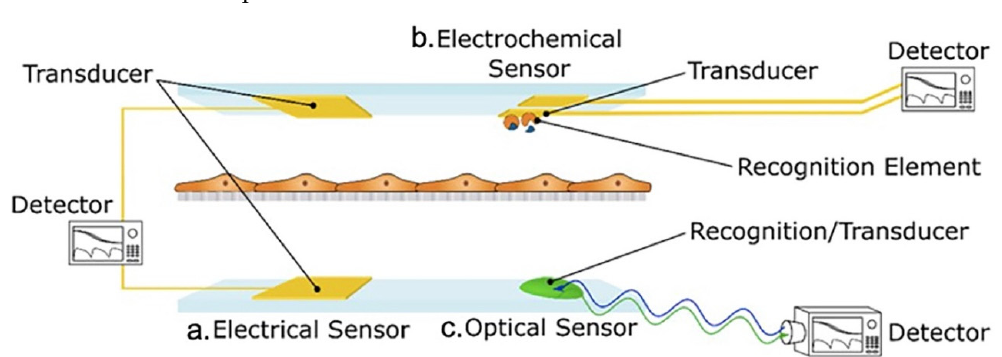
Figure 1. Composition and classification of sensors: Sensors are classified into ( a ) electrical sensors, ( b ) electrochemical sensors, and ( c ) optical sensors. Reproduced with permission from [40].